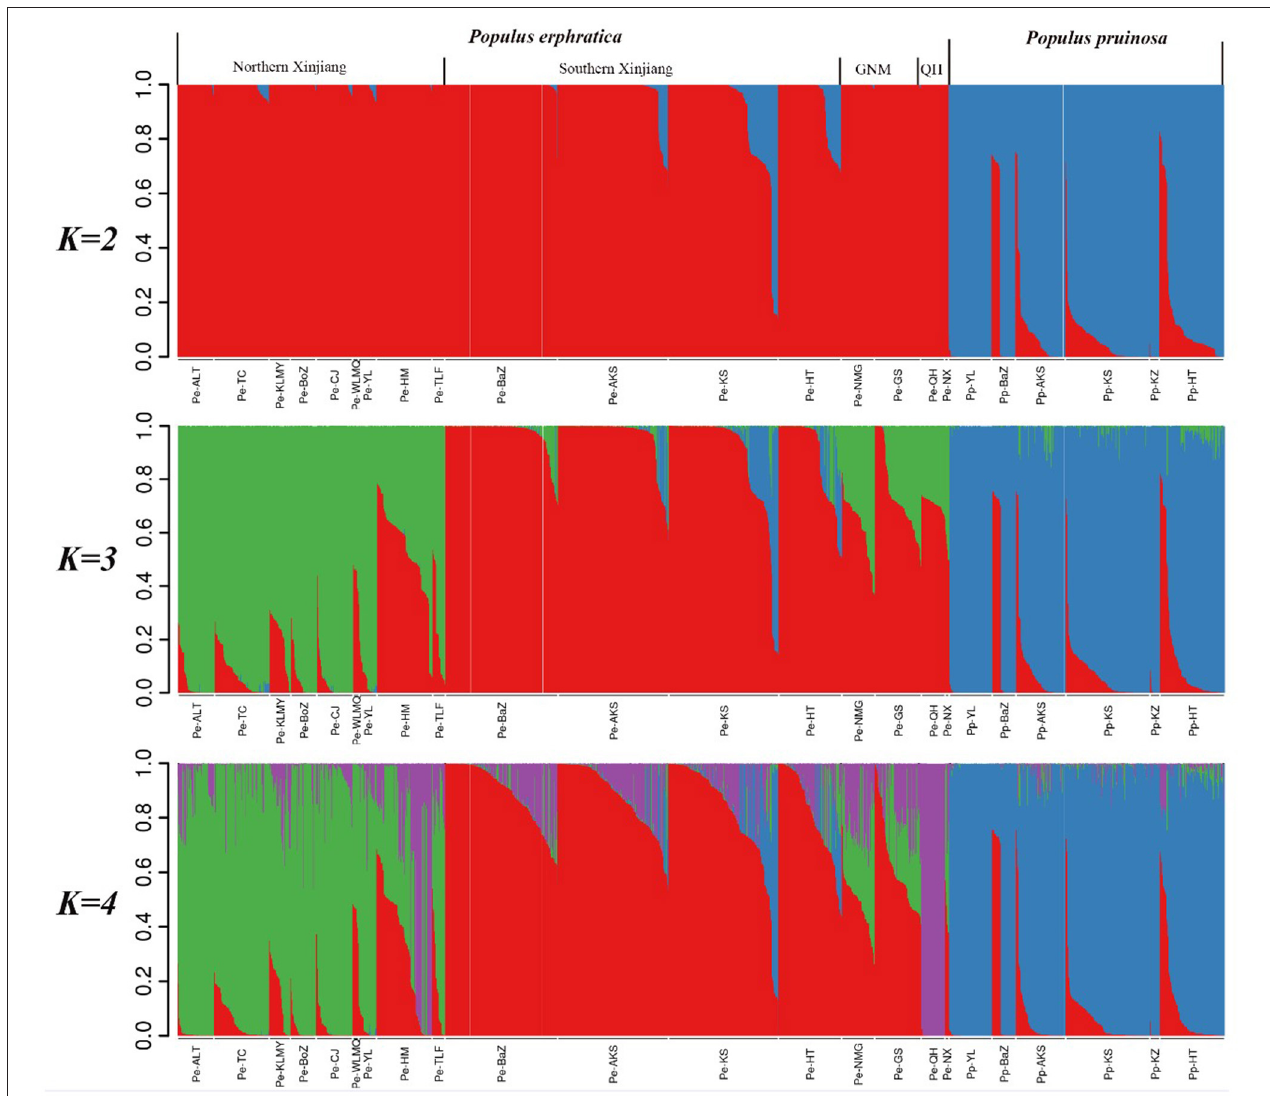
FIGURE 2 | Population stratification for K = 2, 3, and 4 determined using STRUCTURE